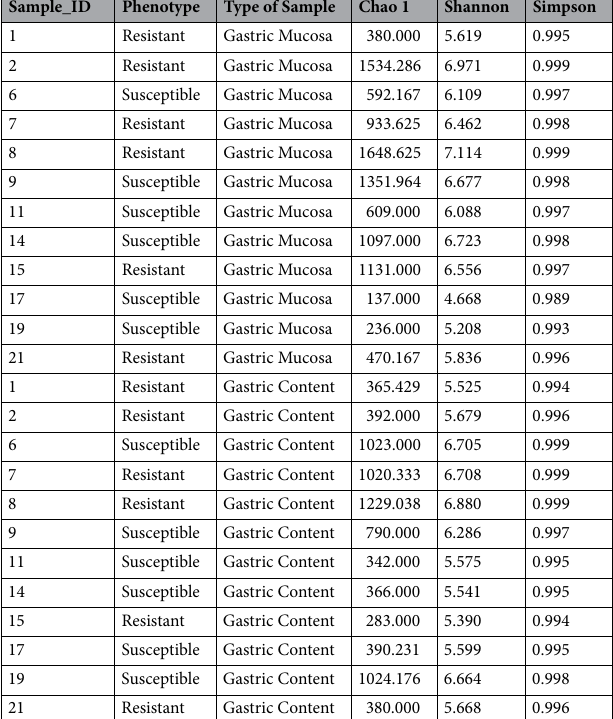
Table 2. Estimation of evenness and richness (Chao, Shannon and Simpson indexes) in gastric mucosa and gastric content samples during T. circumcincta infection . No significant differences between resistant and susceptible animals were observed.